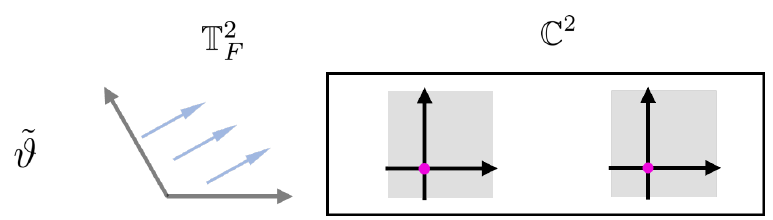
˜ ˜ ϑ . While ϑ leads to an C 2 / Z n orbifold base, renders the total space F